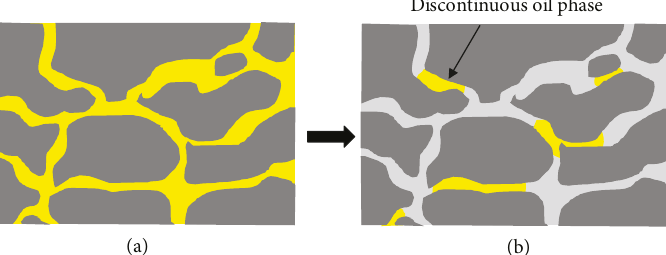
Figure 1: The residual oil in the porous media of the reservoir: (a) before water fl ooding; (b) after water injection development.